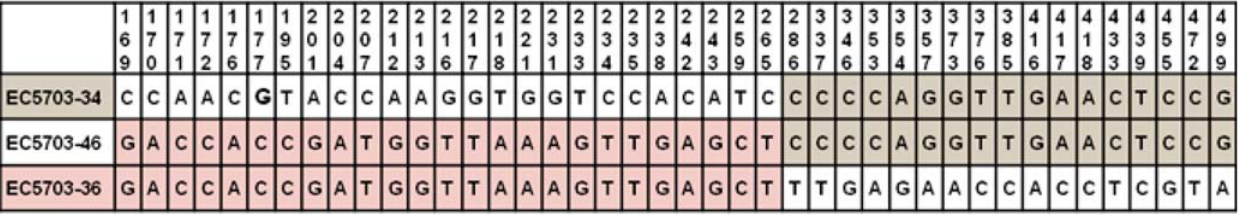
Figure 7. Example of recombination detection in the E1E2 region (EC5703 sample). Variable nucleotide positions in the daughter (EC5703- 46) and two parental sequences (EC5703-34 and